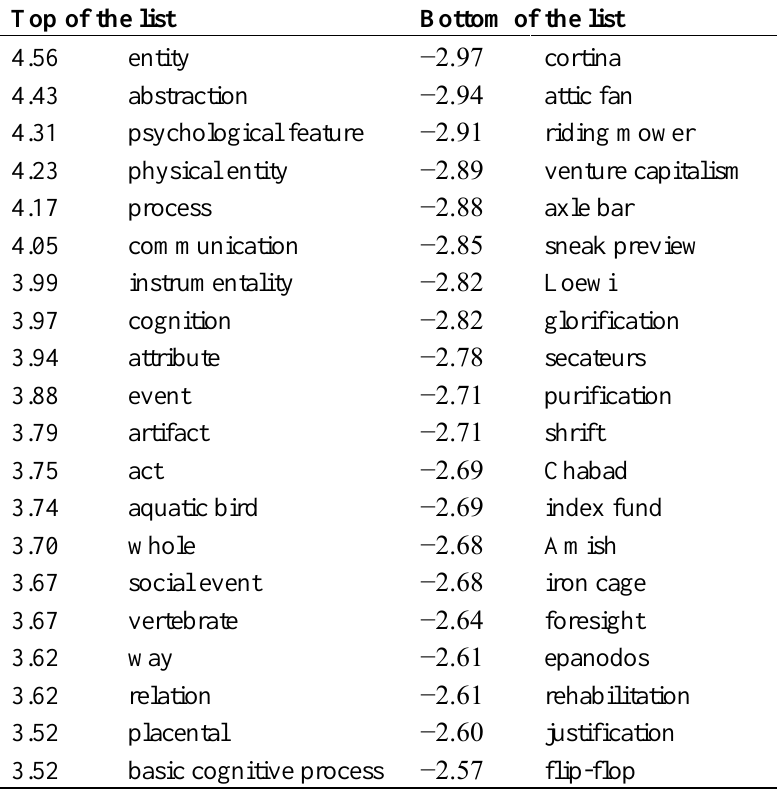
Table 5. Sorted lists of sense-based noun